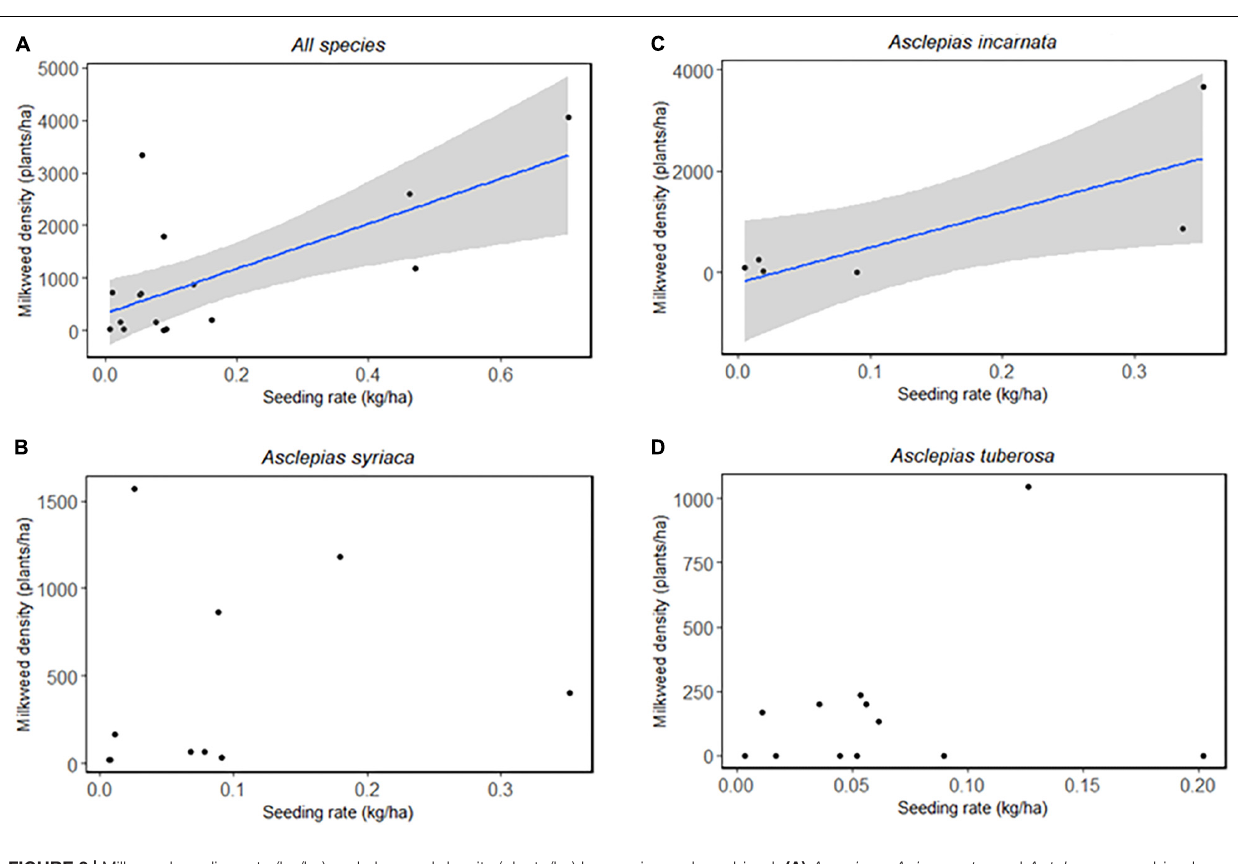
FIGURE 3 | Milkweed seeding rate (kg/ha) and observed density (plants/ha) by species and combined. (A) A. syriaca , A. incarnata , and A. tuberosa combined: Linear model, F